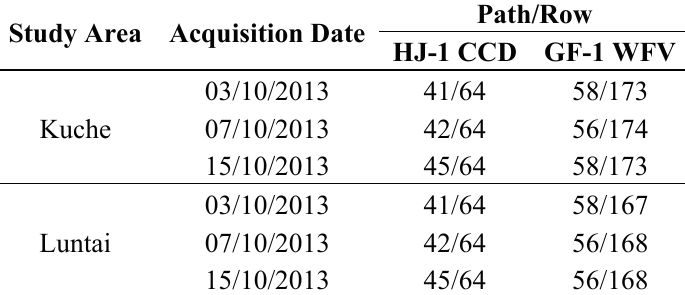
Table 1. Images used in this